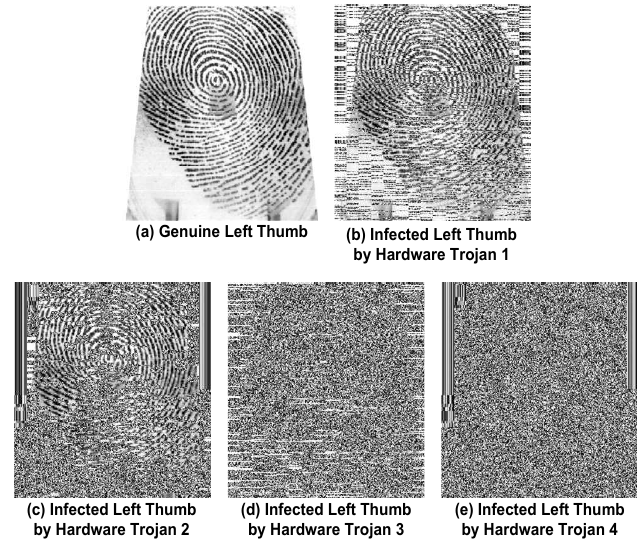
Figure 6. Attack Fingerprint Example (1): The payloads of the Hardware Trojans in sabotaging the image prints of the left thumb.